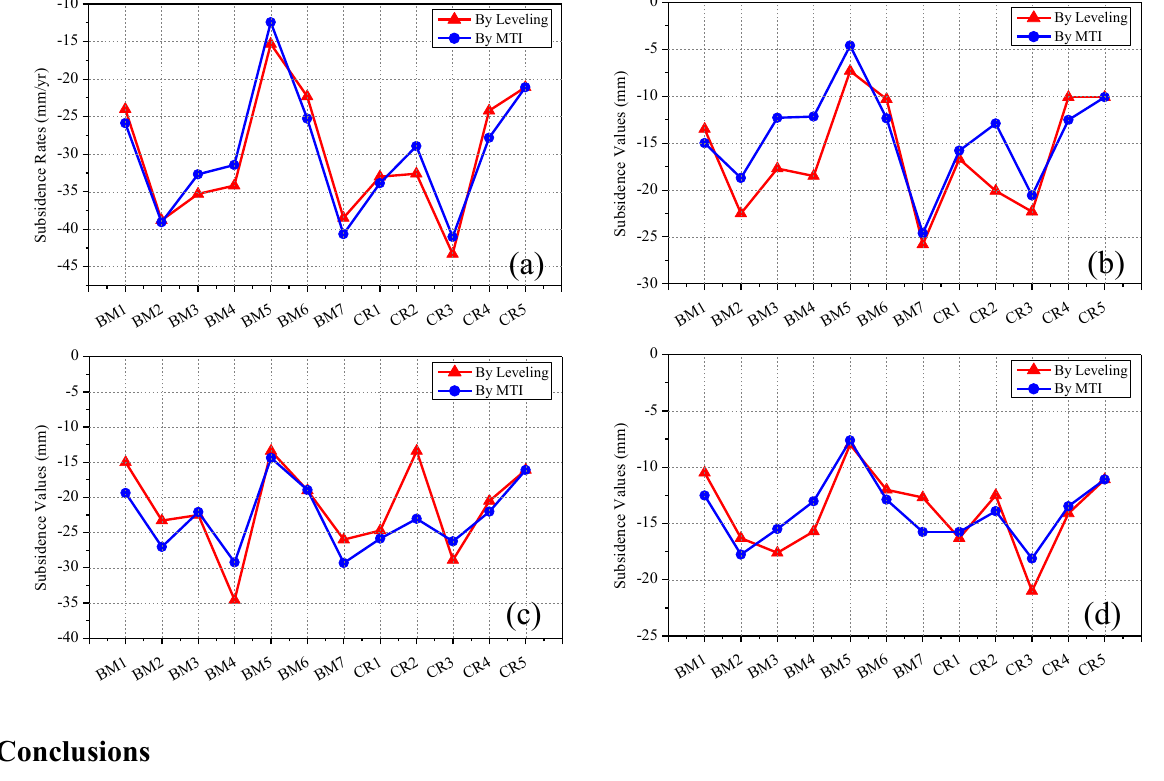
Figure 10. Comparison between subsidence results derived from leveling and from the MTInSAR solution at seven BMs and five CRs ( a ) for subsidence rates; and ( b – d ) for subsidence values over three successive time spans ( i.e ., April to September 2009, September 2009 to April 2010 and April to October 2010),